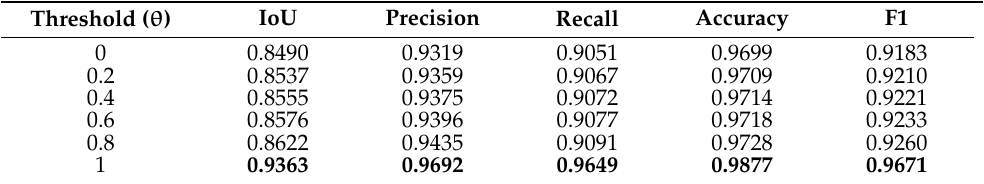
Table 6. Update results obtained by post-processing update strategies with different thresholds on the Wuhan University building change detection dataset. Threshold ( θ ) IoU Precision